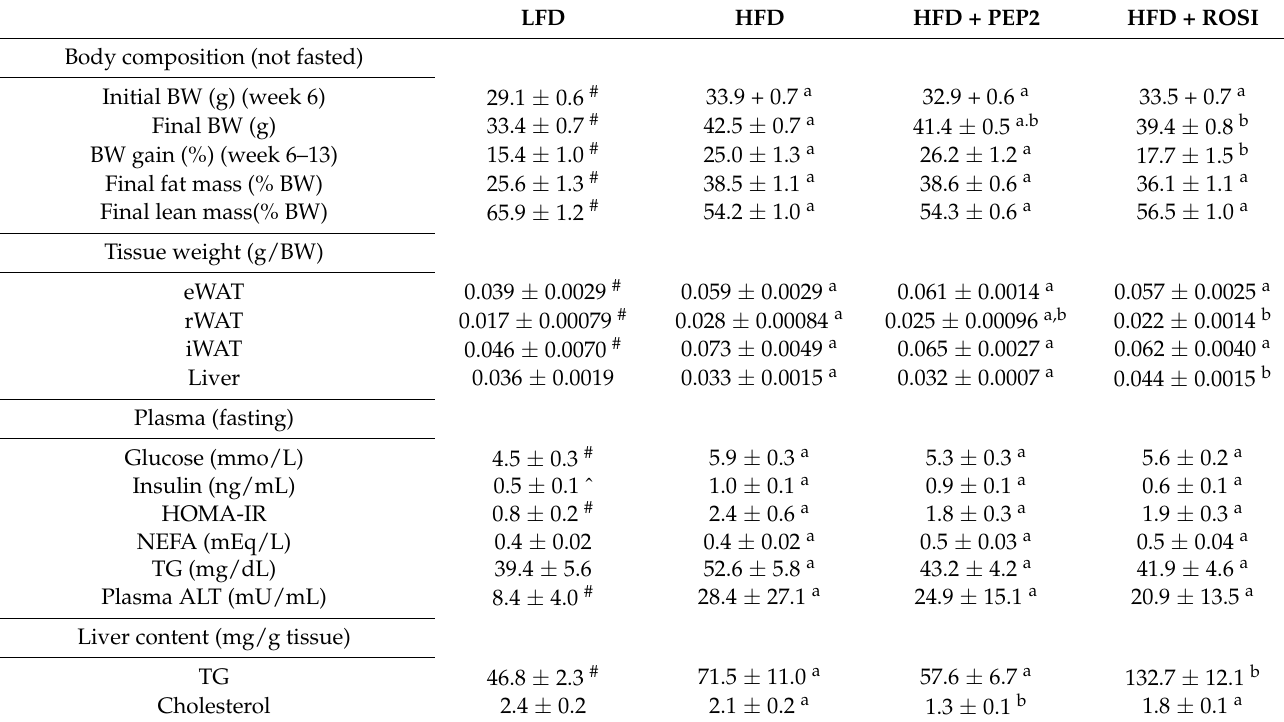
Table 3. Body weight, body composition and plasma profile of C57BL/6 mice at the end of the Peptide 2 feeding trial (Protocol 2). Data expressed as mean + SEM and analyzed by two-tailed t-test (LFD × HFD) and by one-way ANOVA or Kruskal-Wallis (HFD groups). Different letters on the same row indicates p < 0.05 for HFD groups. # Indicates p < 0.05 and ˆ indicates p < 0.1 compared to